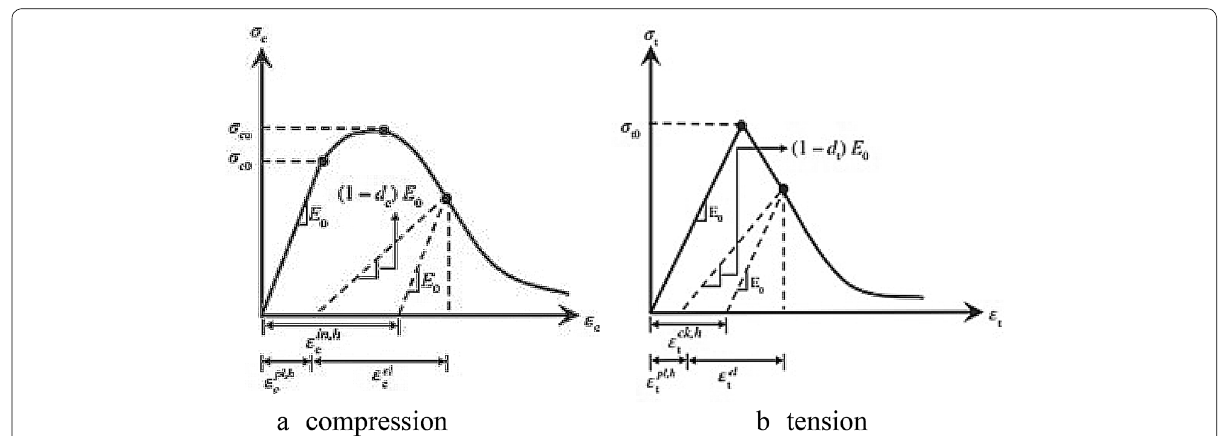
Fig. 8 Behavior of concrete to uniaxial loading stat (Hognestad 1951) confined and unconfined concrete (Kent and Park